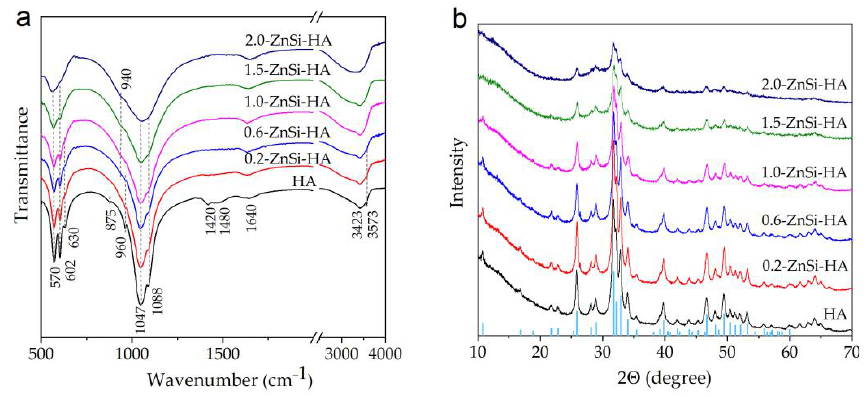
Figure 3. FTIR spectra ( a ) and XRD patterns ( b ) of samples with different dopant concentrations after 40 min of treatment.